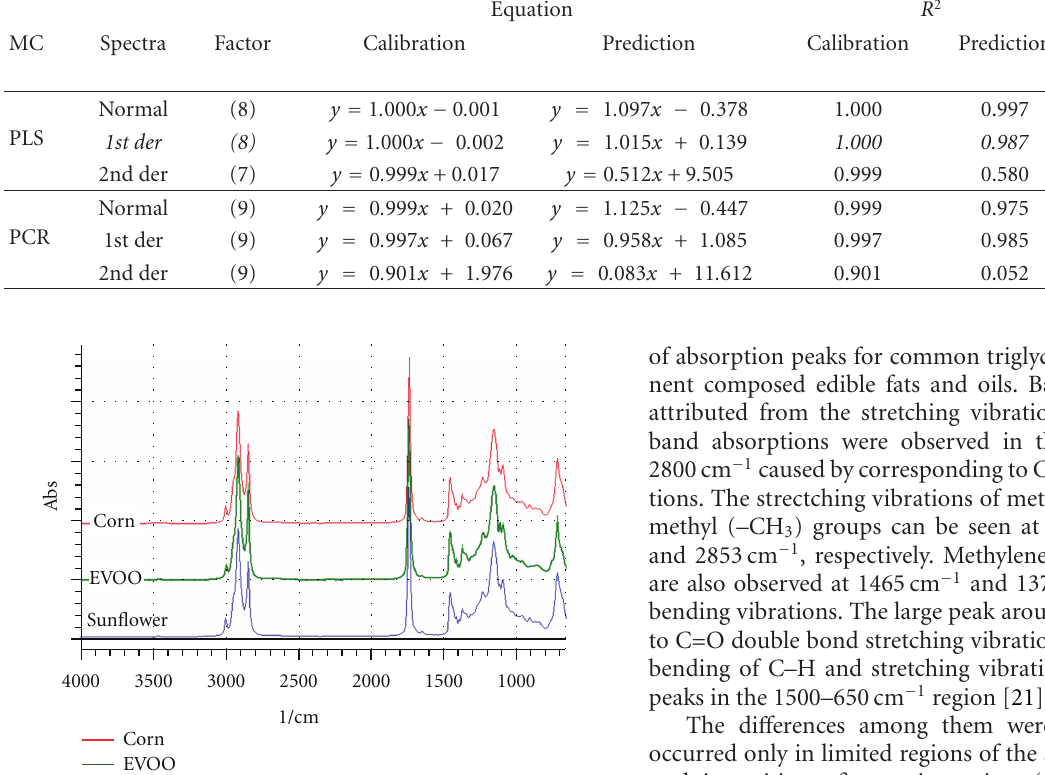
Table 2: The performance of multivariate calibration (MC) and spectral treatments for analysis of sunflower oil in EVOO. Equation R 2 RM